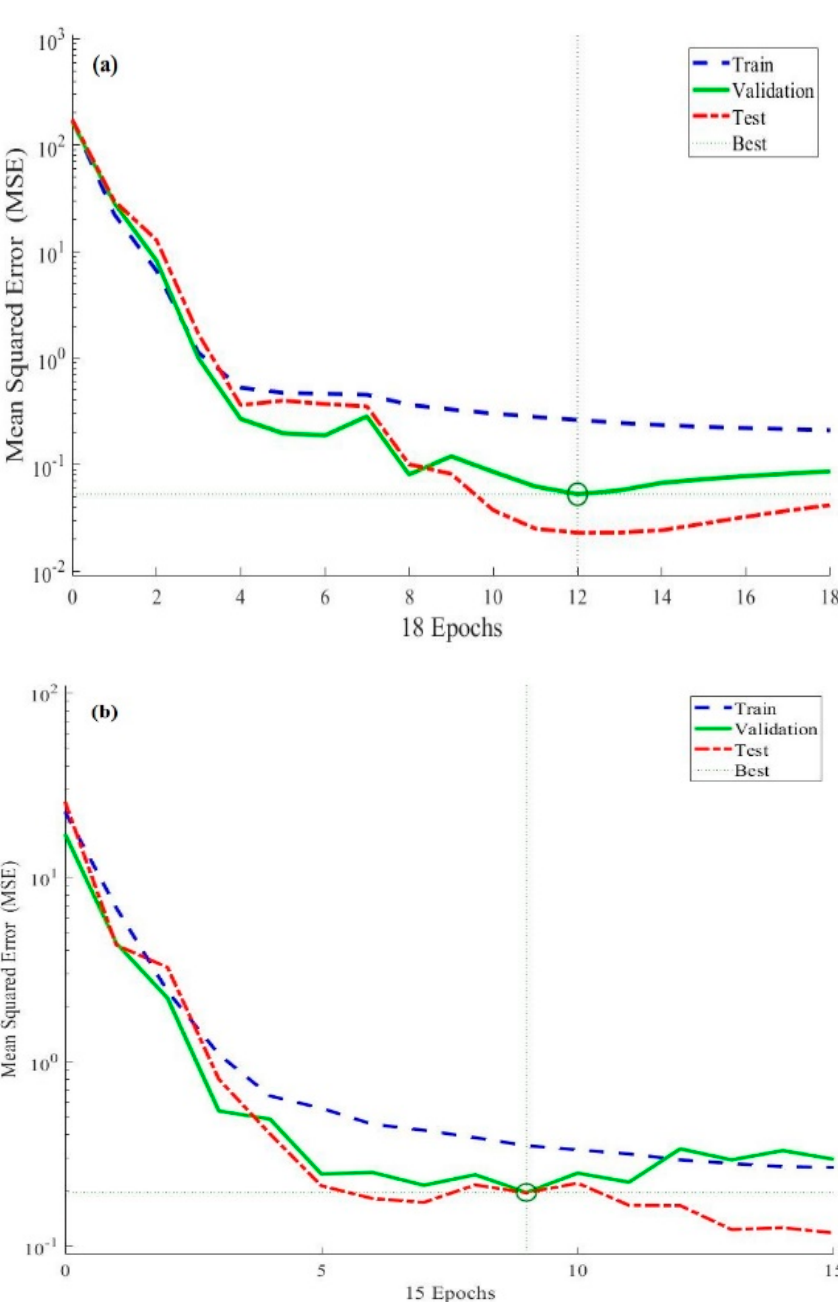
Figure 4. ( a , b ). The training performance graph of the ANN model for M = 0 and M = 0.2. It is seen that the ANN model’s training phases ended with the MSE values obtained for each data set meeting the most optimal position. The error histograms for the ANN model of both magnetized ( M = 0.2) and non-magnetized ( M = 0) flow fields are shown in Figure 5a,b. It should be observed that the calculated error rates for three different data